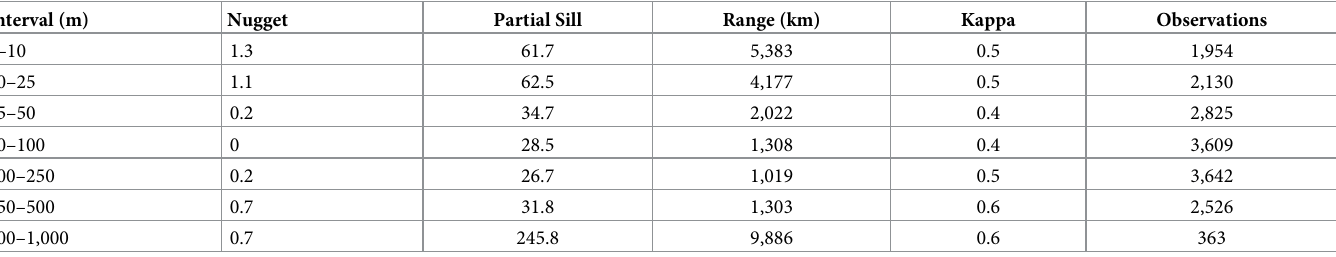
Table 2. Optimized 2-d semivariogram model parameters and number of observations (unique locations) for groundwater δ 18 O values from seven depth intervals. Interval